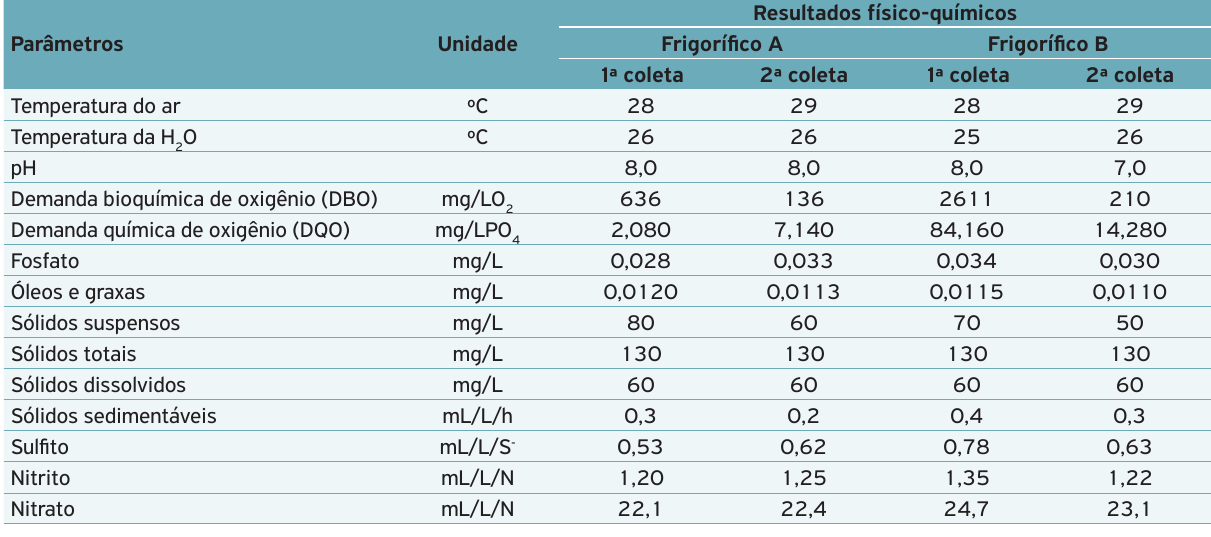
Tabela 3. Resultados físico-químicos de amostras de efluentes líquidos de frigoríficos que abatem bovinos na cidade de São Luís, Maranhão.